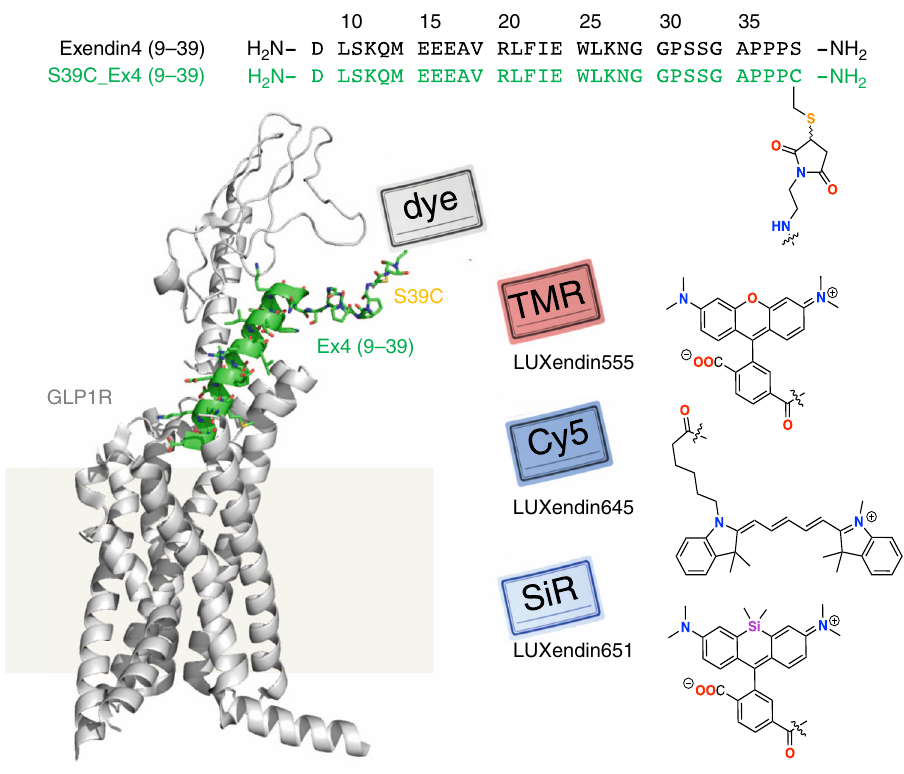
Fig. 1 Sequence and structure of LUXendin555, LUXendin645, and LUXendin651. LUXendins are based on the antagonist Exendin4(9 – 39), shown in complex with GLP1R. The label can be any dye, such as TMR (top), SiR (middle), or Cy5 (bottom) to give LUXendin555, LUXendin645, and LUXendin651 , respectively. The model was obtained by using the cryo-EM structure of the activated form of GLP1R in complex with a G protein (pdb: 5VAI) 62 , with the G protein and the 8 N -terminal amino acids of the ligand removed from the structure while mutating S39C and adding the respective linker. Models were obtained as representative cartoons by the in-built building capability of PyMOL (Palo Alto, CA, USA) without energy optimization. Succinimide stereochemistry is unknown and neglected for